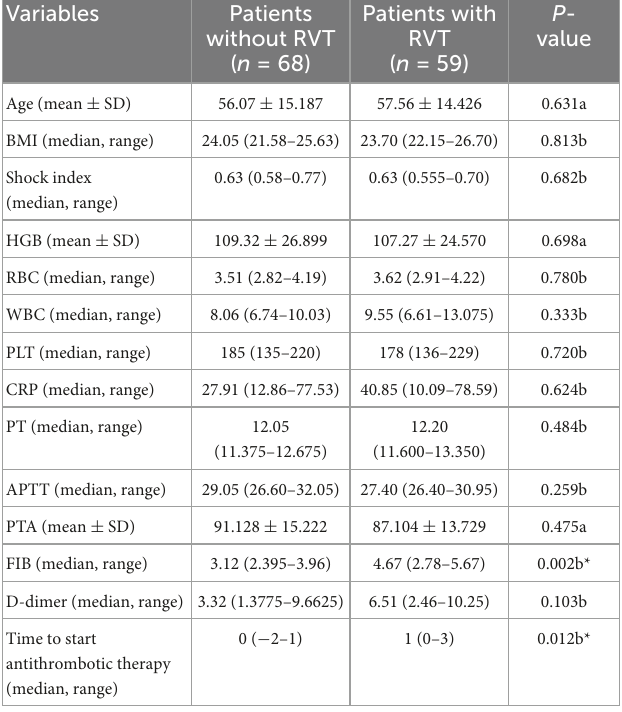
TABLE 1 Comparison of continuous variables in patients with and without residual venous thrombosis (RVT).